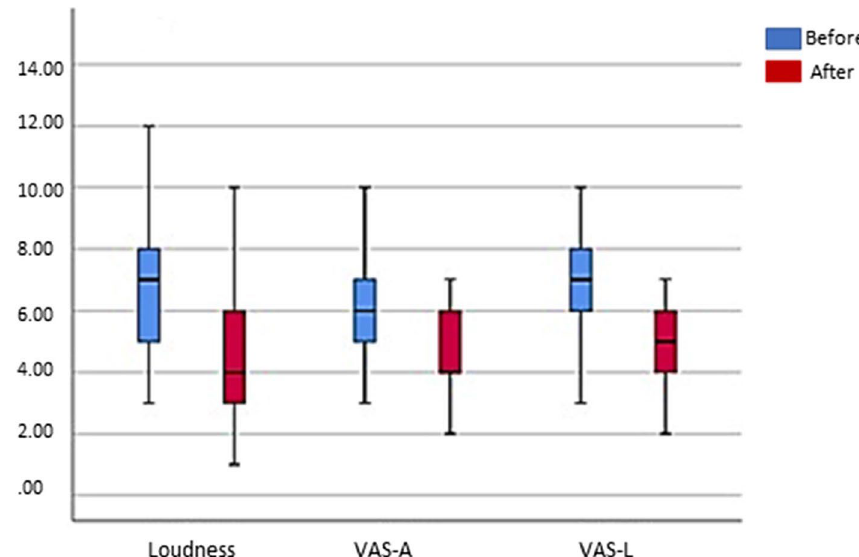
Fig. 3 The boxplot curve of loudness, VAS-L and VAS-A measurements in tinnitus patients before and after BB exposure